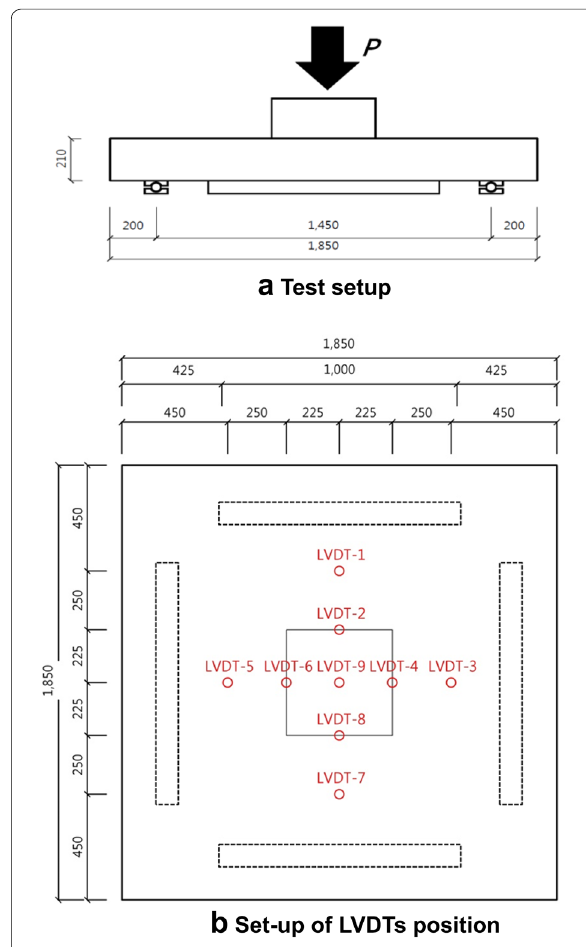
Fig. 2 Test setup for punching shear test. a Test set‑up, b Location of